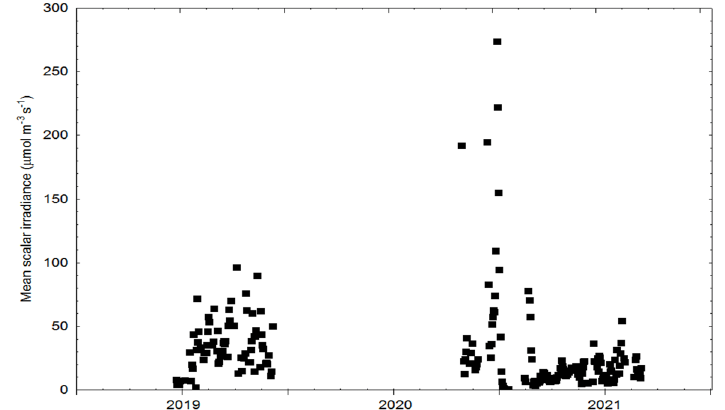
vary 2.5–3.1% [109].